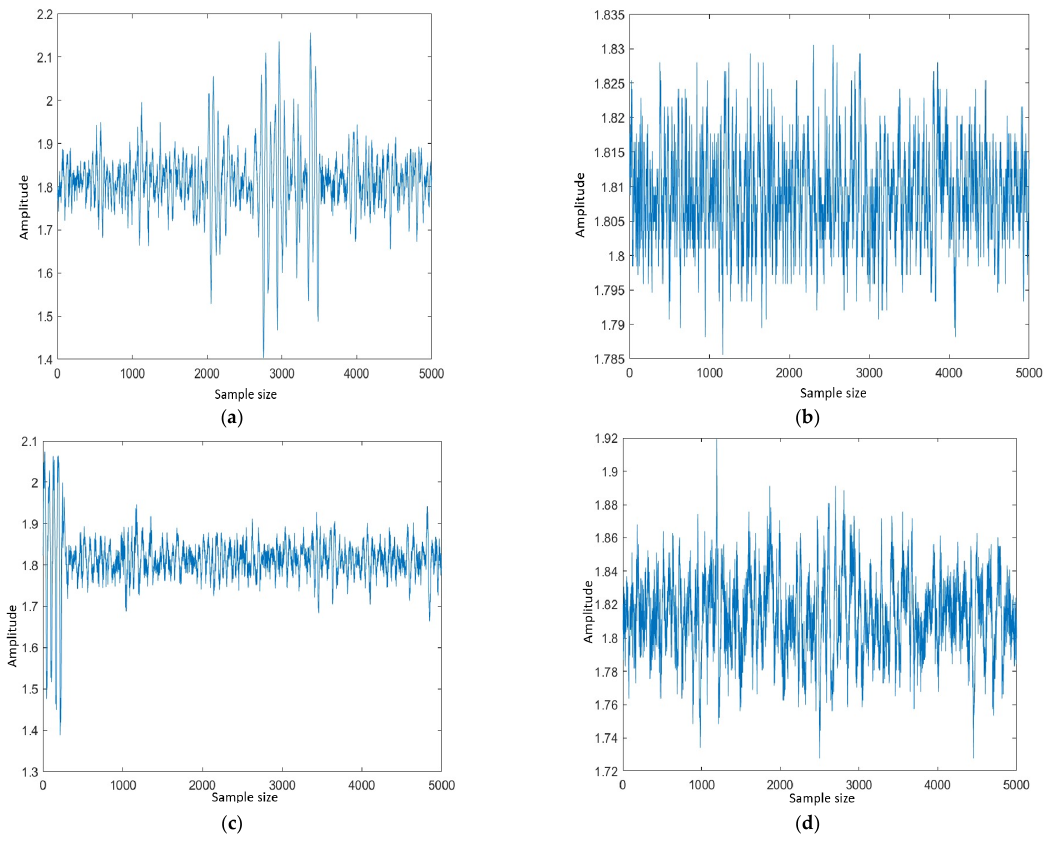
Figure 4. Vibration signals of different conditions used. ( a ) High; ( b ) Idle; ( c ) Normal; ( d ) Punctured.